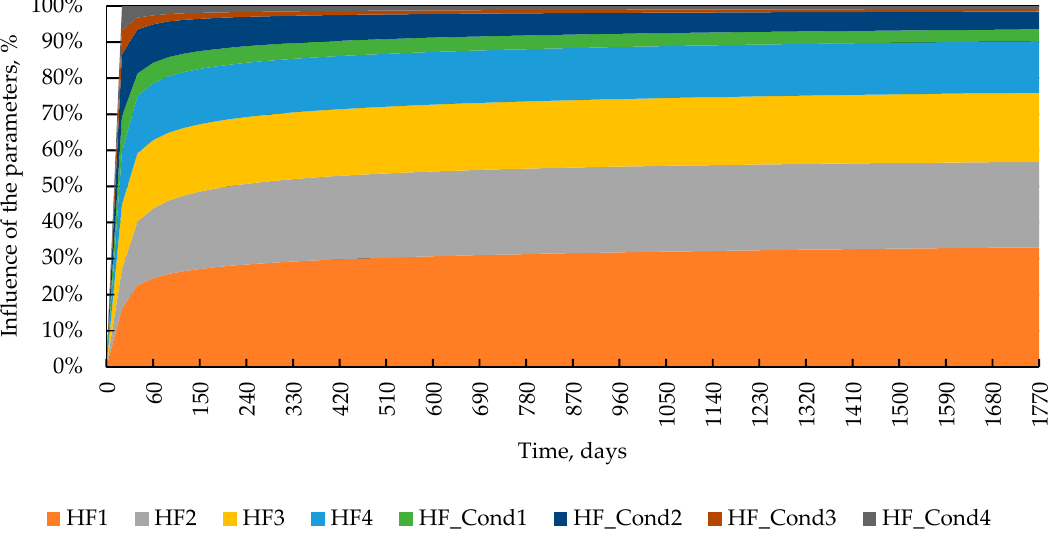
Figure 9. Influence change of each parameter. (HF#, hydraulic fracture length; HF_Cond#, hydraulic fracture conductivity; # = 1, 2, 3, and 4 denote the location of hydraulic fracture stage.)